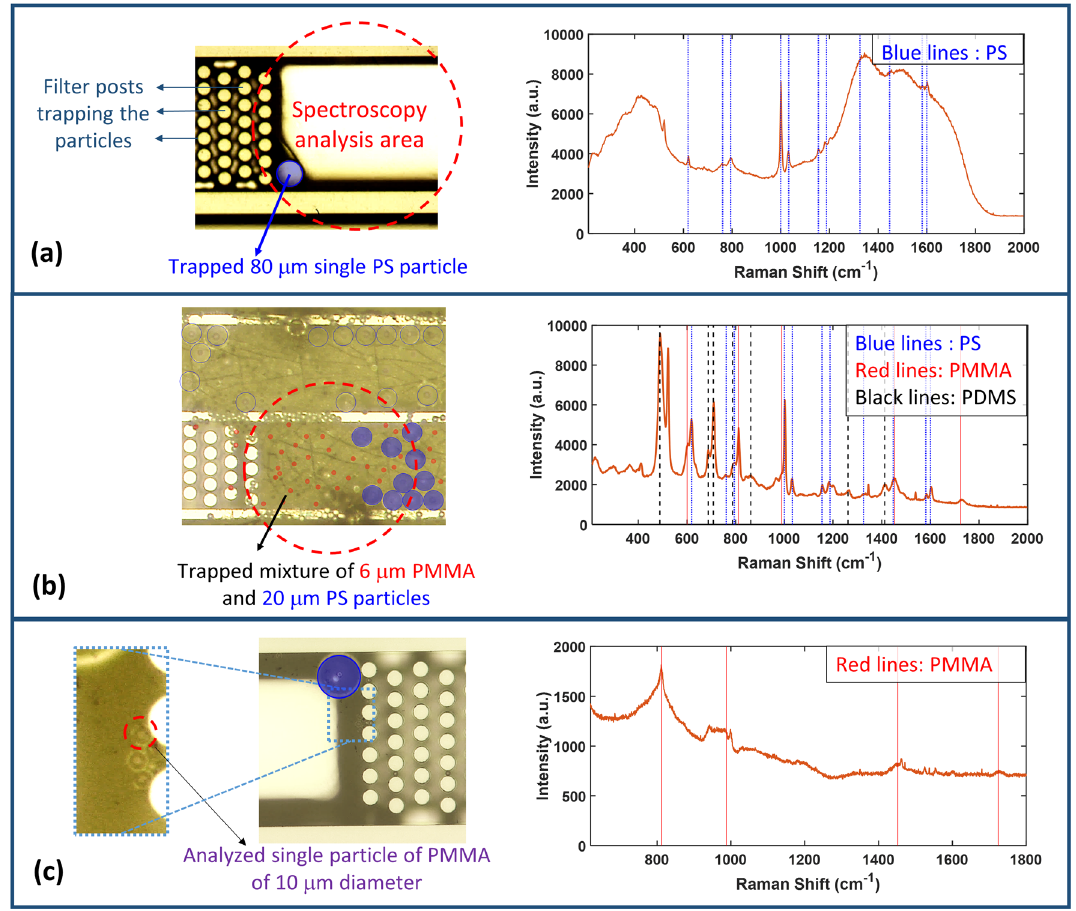
Figure 5. Raman spectrometer and Raman microscope measurements. ( a ) A microscope image of the chip reservoir containing a trapped PS particle of diameter 80 µm, along with the obtained spectrum for this particle using the Raman spectrometer. ( b ) A microscope image of the chip reservoir containing a mixture of 6 µm PMMA particles and 20 µm PS particles, along with the obtained spectrum for this mixture using the Raman spectrometer. ( c ) A microscope image of the chip reservoir containing a number of particles, where only one particle is selected and analyzed (PMMA 10 µm) using the Raman microscope with the help of the small-spot size of 1 µm. ( a – c ) Dashed-line red circles denote the area of the incident light spot for the